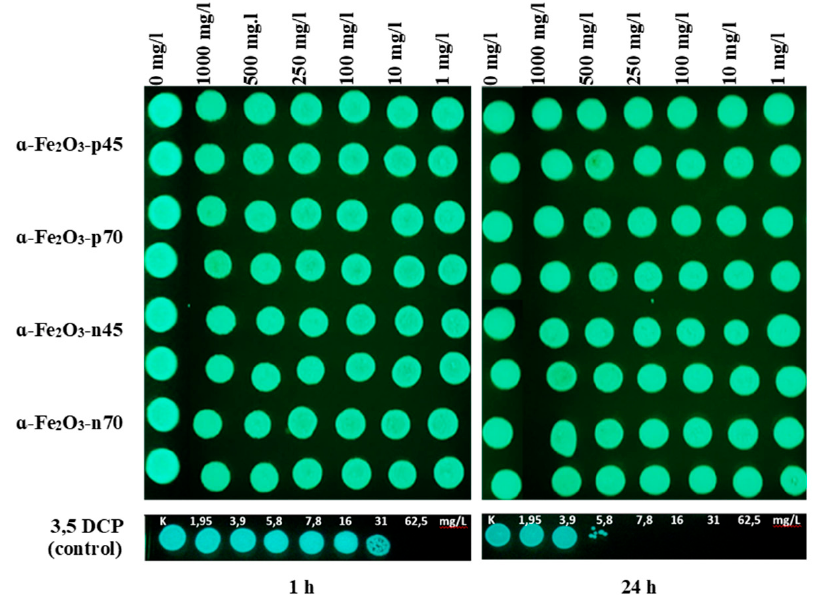
Figure 8. Viability of Vibrio fischeri after exposure to α -Fe 2 O 3 NPs in 2% NaCl for 30 min and 24 h at room temperature. Viability was evaluated by the ability of exposed bacteria to yield colonies at the Beneckea Harvey (BH) agar plate as indicated on the panels. Blue-green spots are bioluminescent bacterial colonies photographed in the dark; 3,5-dichlorophenol (3,5 DCP) was used as a positive control.